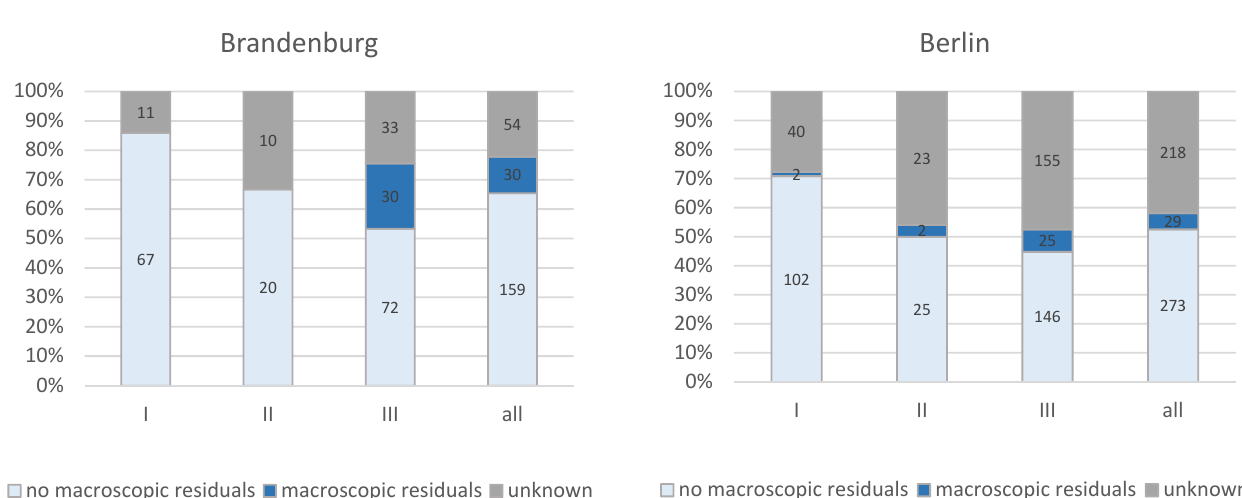
Figure 5. Percentages of macroscopic complete resection according to FIGO stages and federal states Berlin vs. Brandenburg ( n = 763; FIGO stage I: n = 222, FIGO stage II: n = 80, FIGO stage III: n = 461).